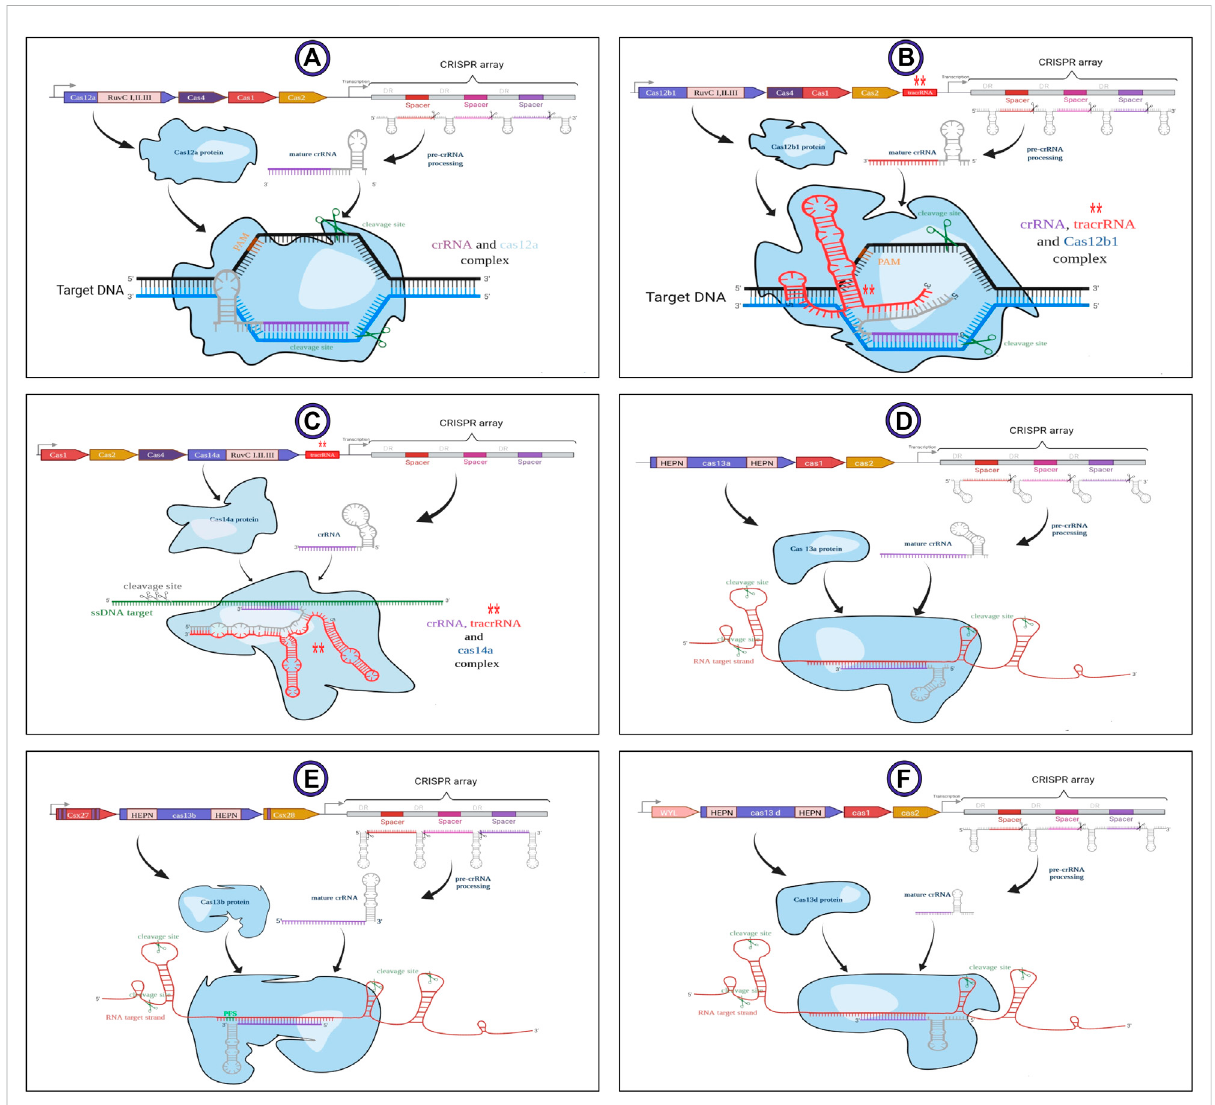
FIGURE 2 Schematic structure of the subtypes of V and VI types related to class II of CRISPR-Cas system. Generalized locus along with their main details illustratedinsections (A) V-A, (B) V-B1, (C) V-F1, (D) VI-A, (E) VI-B,and (F) VI-D.LwaCas13arequiresspacersofatleast20ntlengthbutshorterspacers have lower ef fi ciency. AapCas12b and Cas14a are dual-RNA-guided endonucleases that require association with a structural accessory RNA named transactivating CRISPR RNA (tracrRNA) for their activity. This image was created using